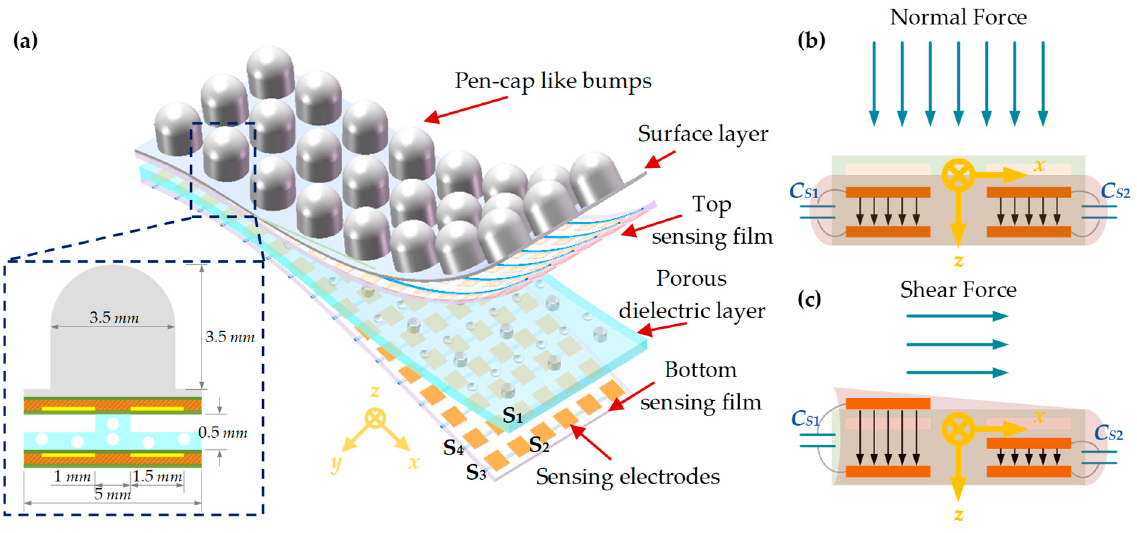
Figure 1. The schematic diagram of the capacitive tactile sensing array: ( a ) Detailed structure of unit sensing element; ( b ) A unit sensing element under normal force; ( c ) Under shear force.